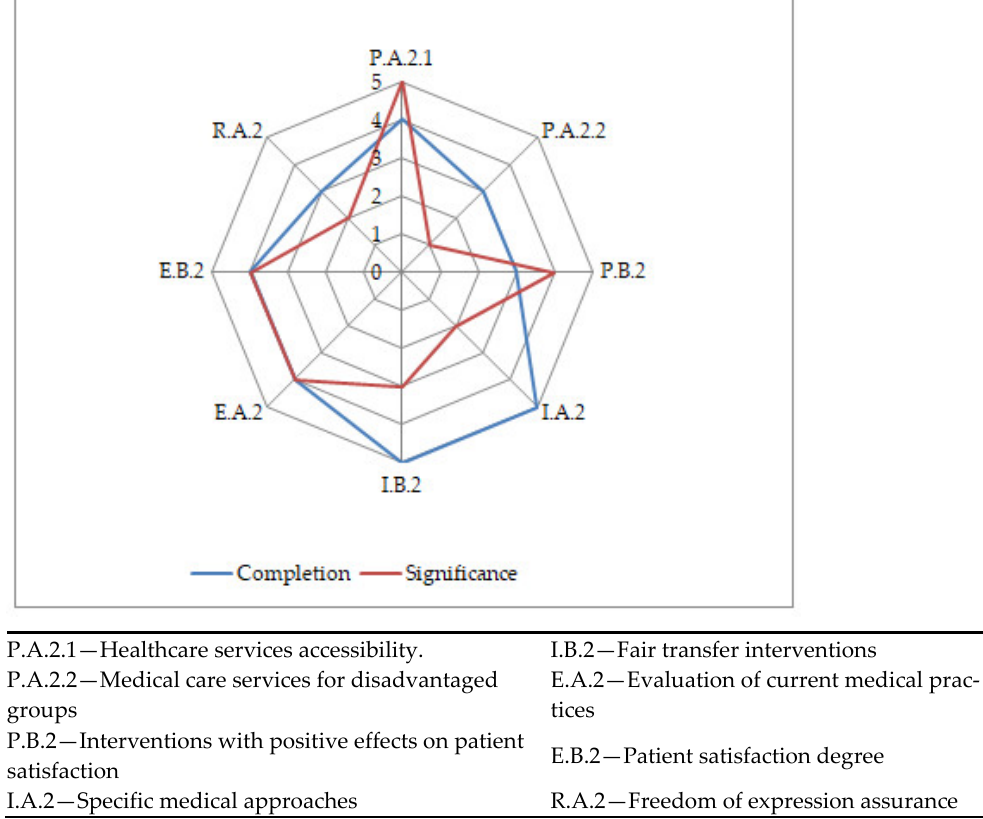
Figure 6. Human rights sustainability assessment chart.